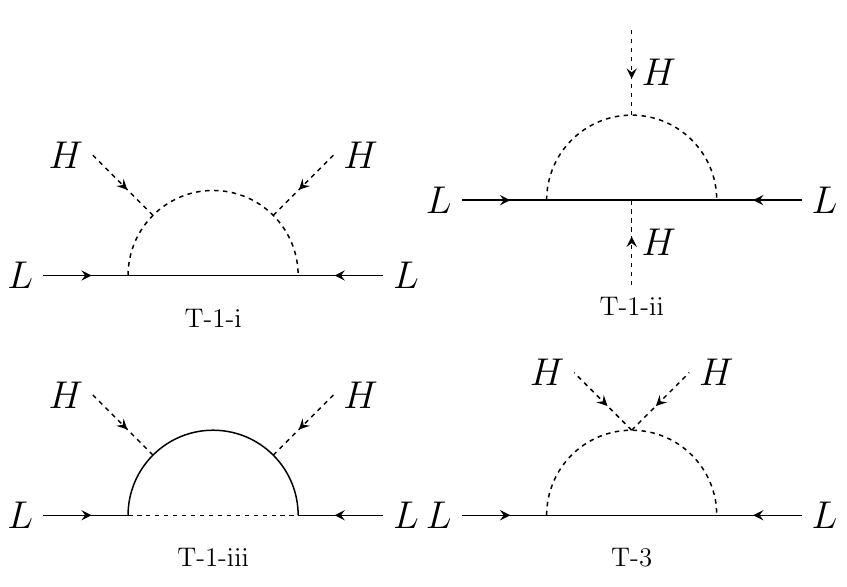
Figure 2 . The four genuine d = 5 1-loop neutrino mass diagrams in the notation of